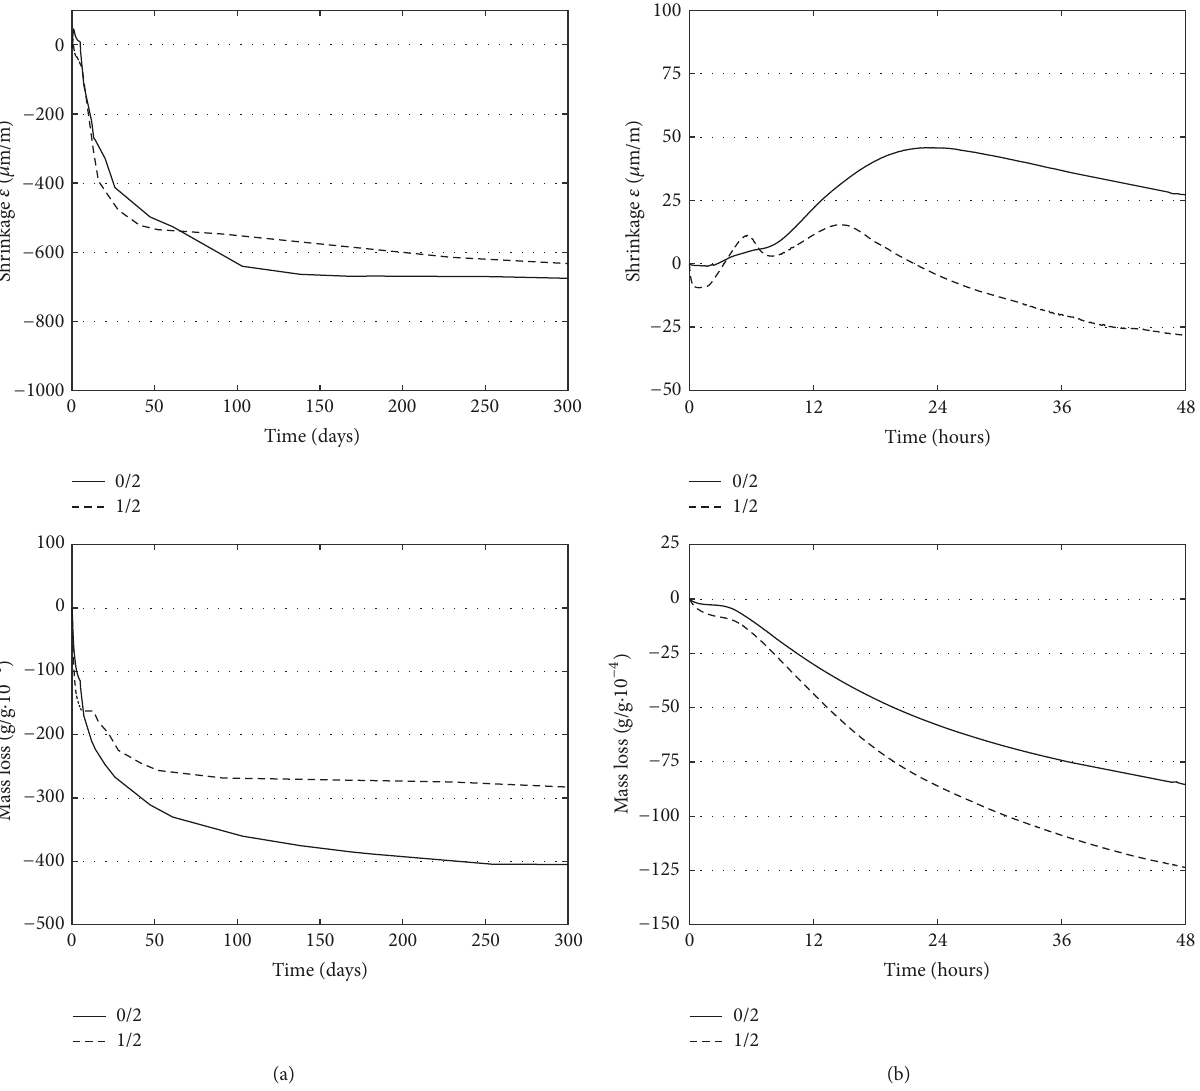
Figure 6: Progress of shrinkage/swelling and mass loss for concretes 0/2, and 1/2 ((a): measurement over the whole time of setting and hardening; (b): early age